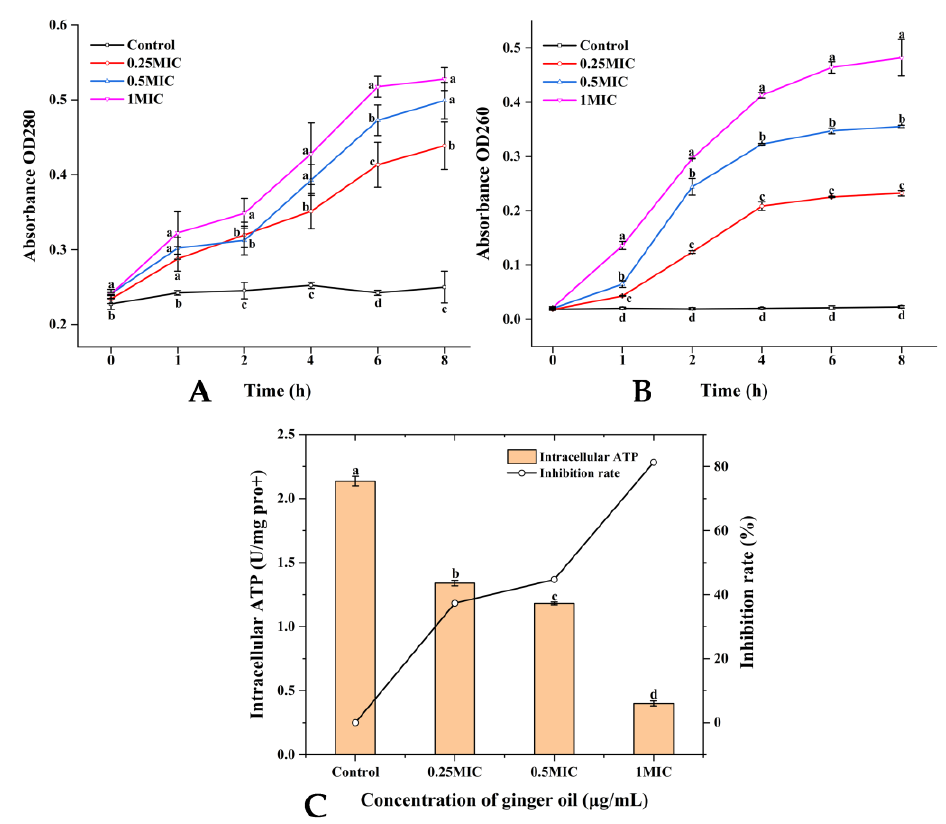
Figure 1. Analysis of ( A ) Nucleic acids level, ( B ) Protein level, and ( C ) Intracellular ATP. ( A , B ) express changes in nucleic acids and proteins of S. putrefaciens over time and in response to changes in GEO concentration. ( C ) represents the changes of intracellular ATP content in S. putrefaciens with the change in GEO concentration. Different colors in ( A , B ) indicate different concentrations (Black—Control, Red—0.25 MIC, Blue—0.5 MIC, Violet—1 MIC). Different lowercase letters indicate significant difference( p < 0.05).